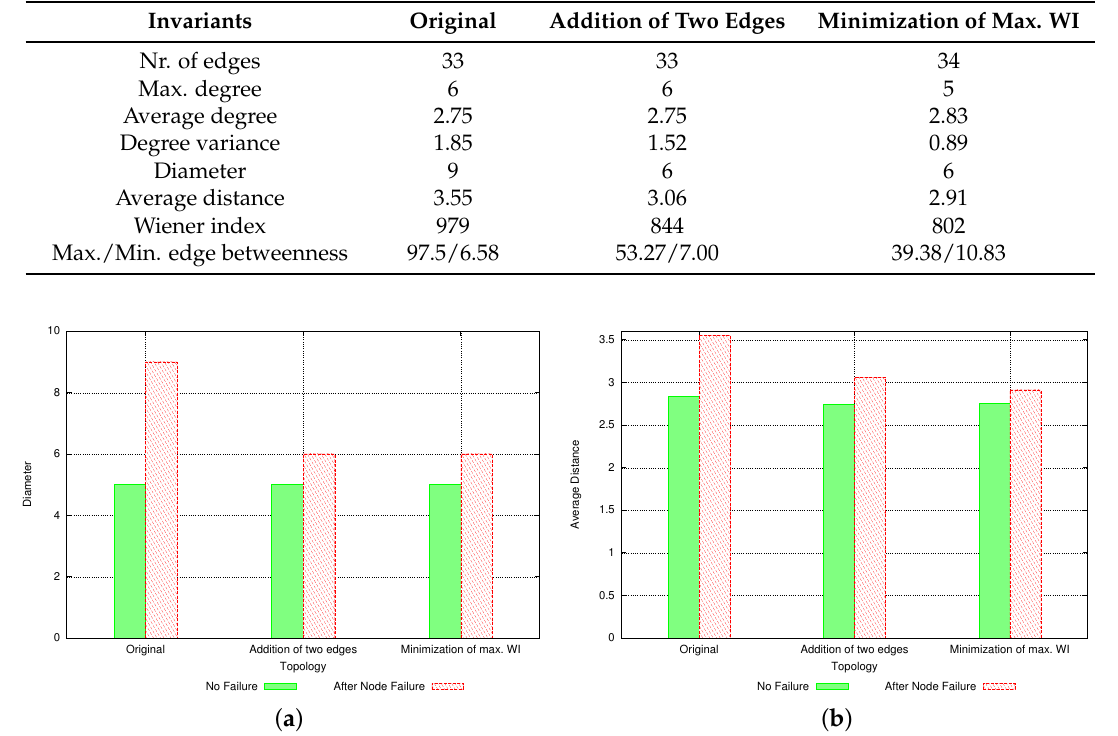
Table 6. RNP backbone after the worst case node failure (max. WI).